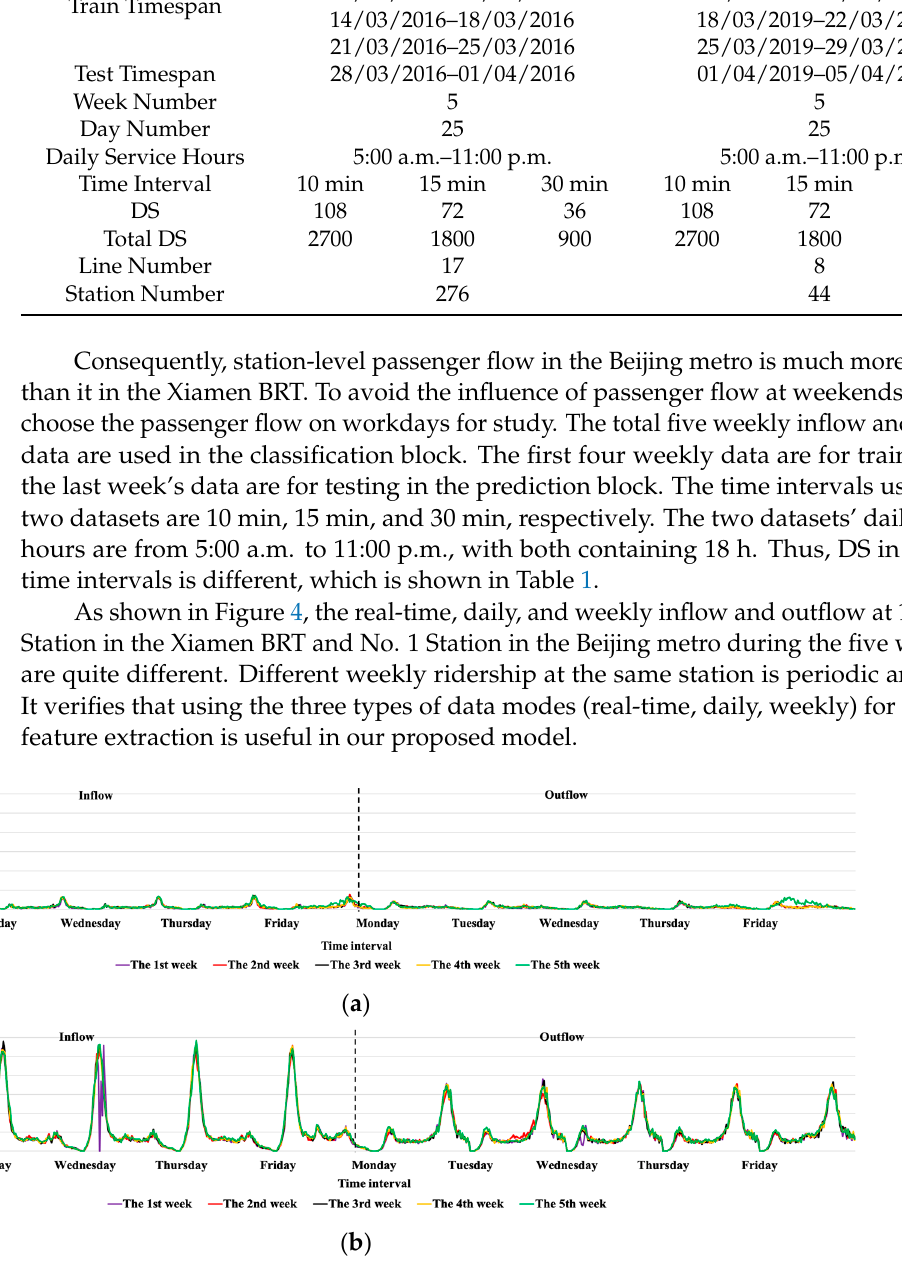
Table 2. Parameters used in the classification block. Parameters